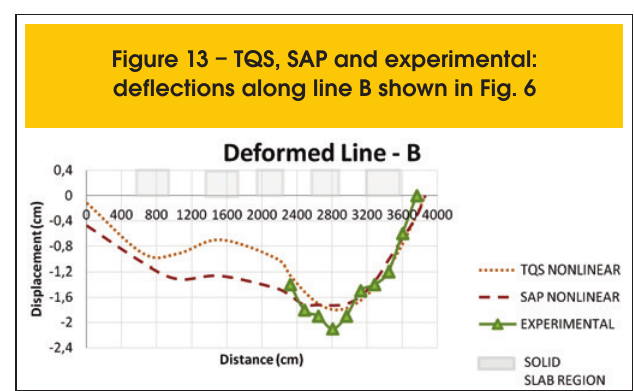
Figure 12 – TQS, SAP and experimental: deflections along line a shown in Fig. 6